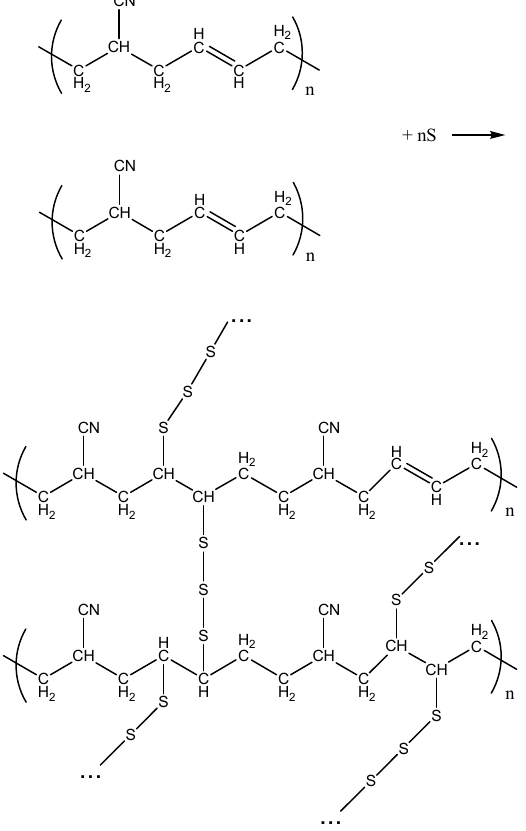
with ED-20 epoxy groups, the rubber crosslinking occurs only due to the interaction of molecular sulfur with regard to double bonds of the rubber. The crosslinked structure is formed according to Scheme 1: